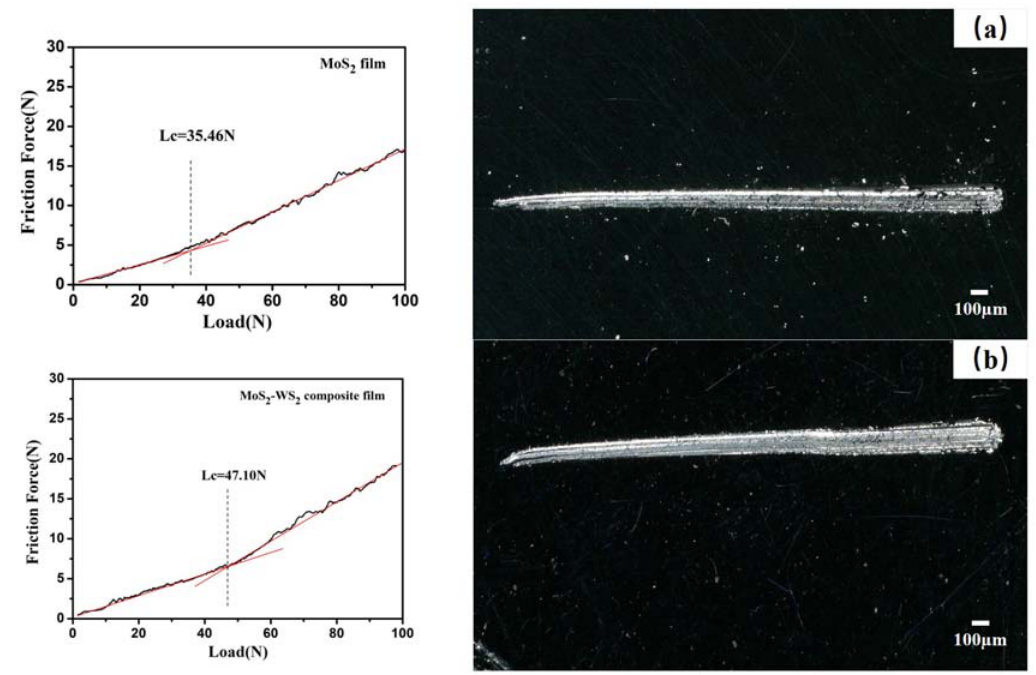
Figure 6. Scratch curves and tracks of MoS 2 film ( a ) and MoS2–WS2 film ( b ).